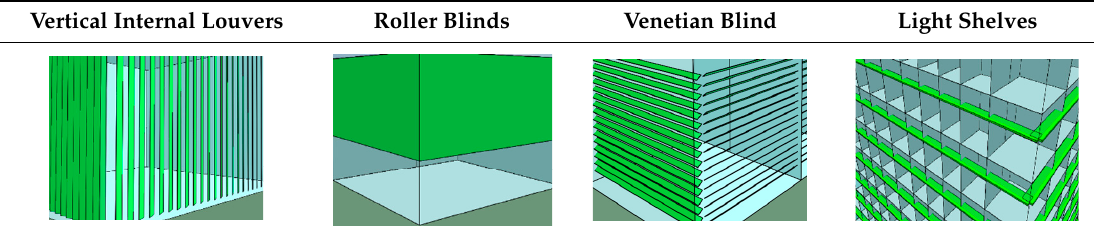
Table 2. Internal shading simulated.